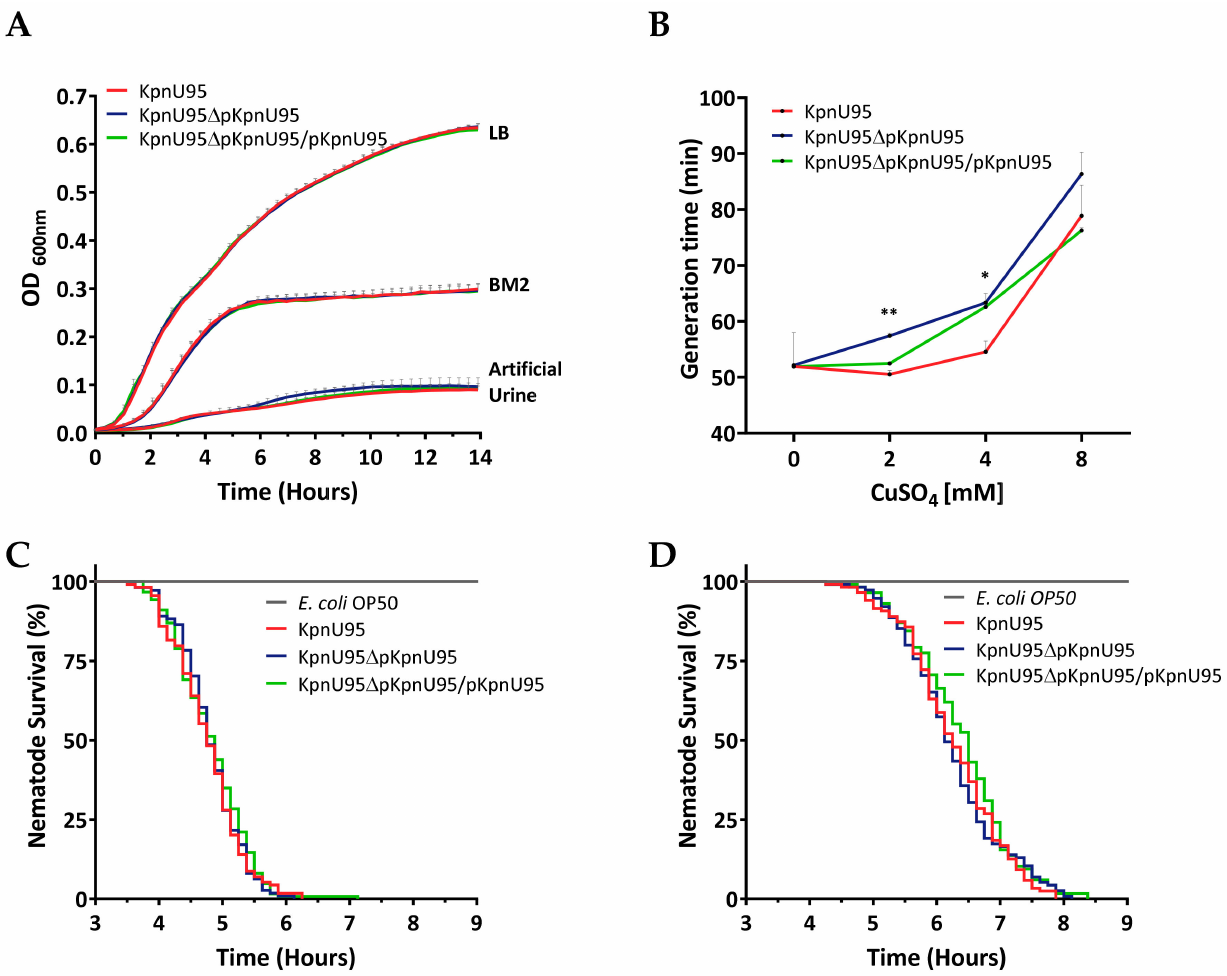
Figure 2. Growth kinetics, copper tolerance and virulence assessment of KpnU95 strains. Growth curves of KpnU95 strains in rich media LB, minimal BM2 medium and on artificial urine were performed in 96-multiwell plates by monitoring OD600 nm during 14 h. Each growth curve represents the average of three or five independent experiments ( A ); Copper tolerance in MH in different concentrations of CuSO 4 . The doubling time of each growth curve represents the average of three independent growth experiments. * p value ≤ 0.05 and ** p value ≤ 0.01 ( B ); The survival curves of C. elegans nematodes fed on KpnU95 strains or E. coli OP50 as a control strain in BM2 ( C ) or on artificial urine media ( D ). The nematode survival curves were plotted according to the average survival counts of two replicate experiments performed in four replicate wells. Statistical analysis was performed using the Log-rank (Mantel–Cox) test ( C , D